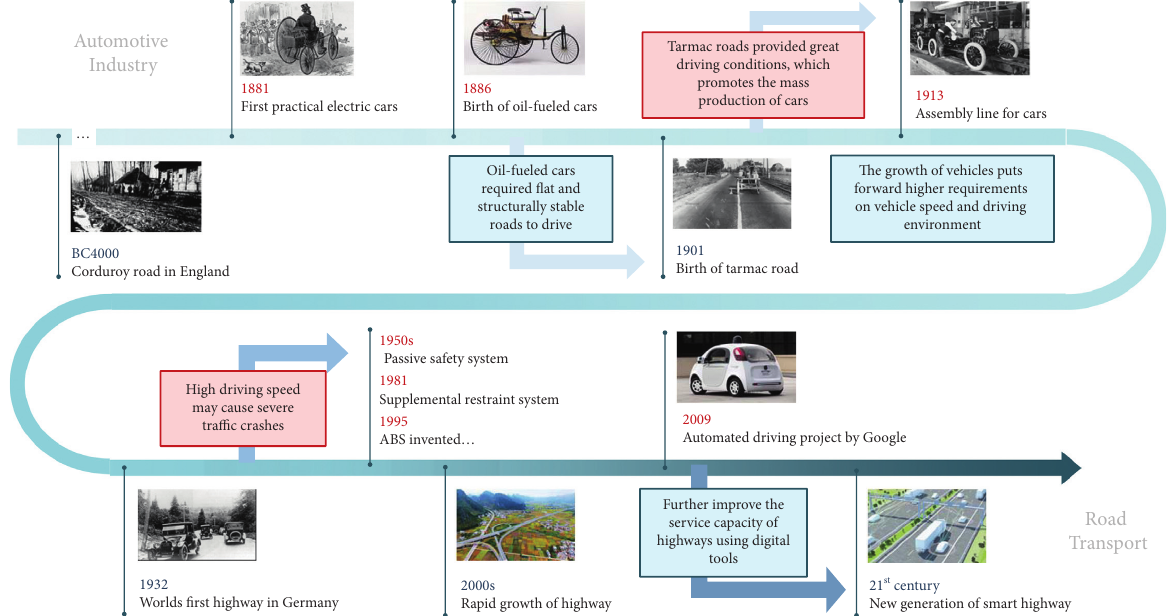
Figure 1: Interactive development of automobile industry and road